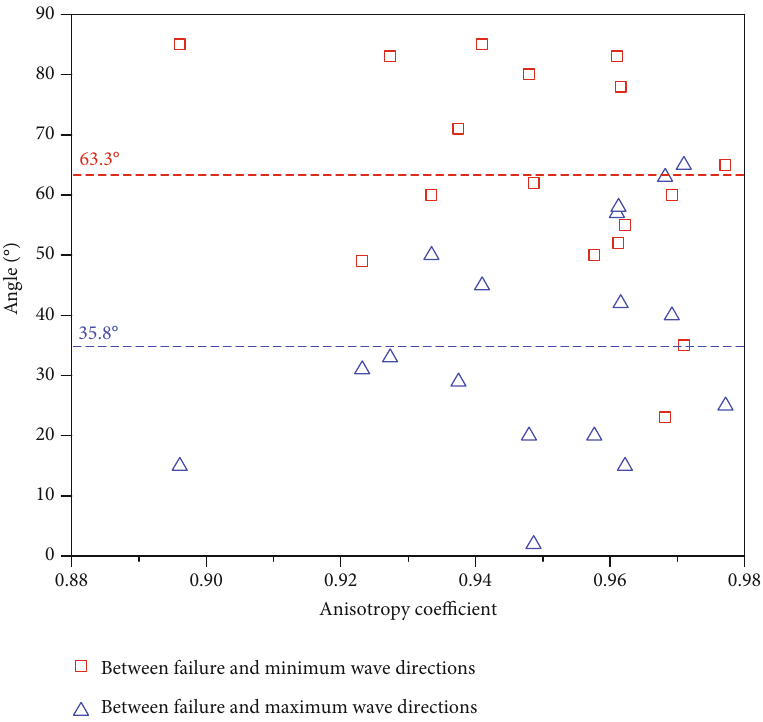
Figure 8: Angles between the failure plane and the minimum and maximum wave directions in di ff erent rock